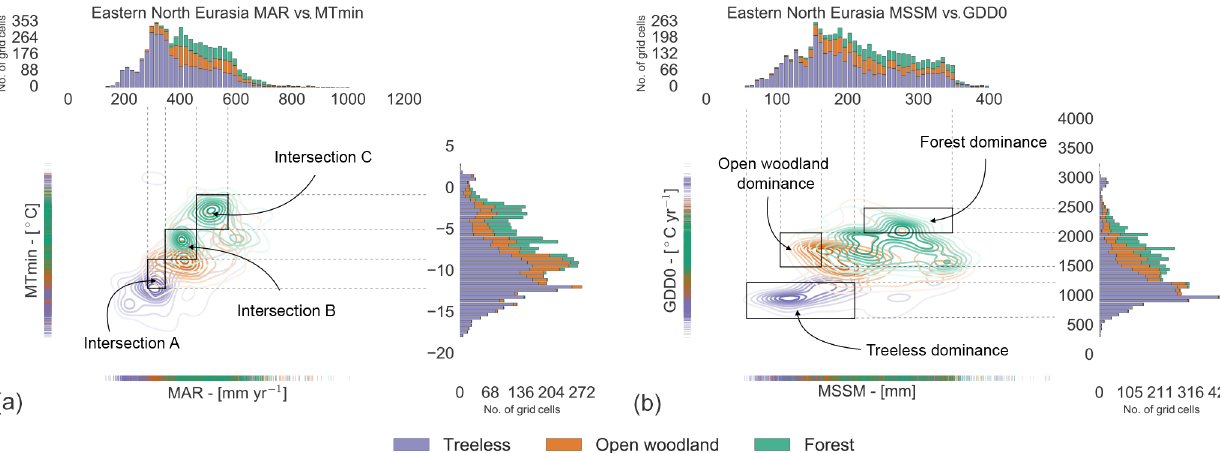
Figure 2. Representation of the KDEs of the three vegetation states in the phase space generated by mean minimum temperature and mean annual rainfall (a) , and mean spring soil moisture and growing degree days above 0 ◦ C (b) , for eastern North Eurasia. Vegetation states are colour-coded as follows: green for forest, orange for open woodland, and purple for treeless. The isolines describe the probability of finding the three vegetation states under the specified environmental variables regimes, with intense colours indicating higher probabilities. Highlighted intersections in phase space represent areas with different vegetation states under the same environmental conditions (a) , whereas the marked areas with only one dominant state hint at the unimodality of the underlying distribution (b) . Marginal distributions for the variables are reported to the sides of the plots in the form of histograms.